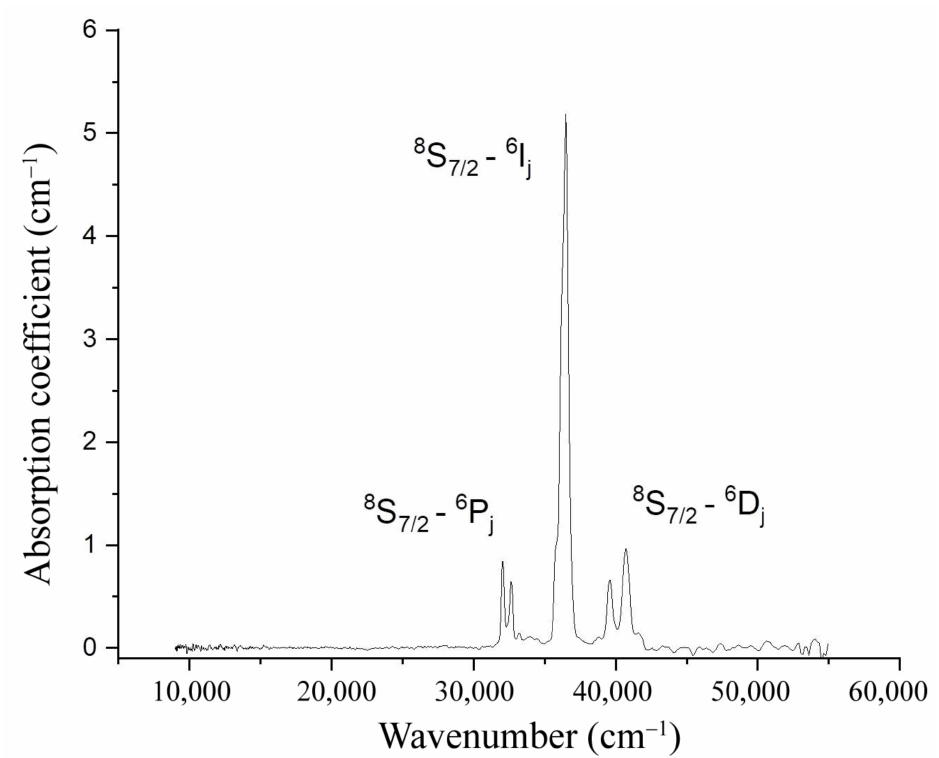
Figure 2. Non-polarized room-temperature absorption spectrum of LiGdF 4